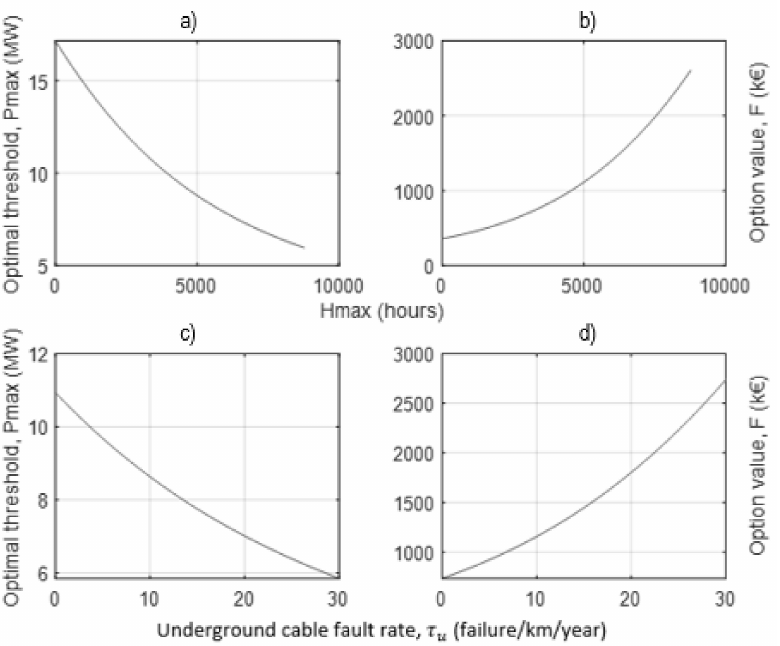
Figure 17. Sensitivity analysis of Hmax and underground cable fault rate for optimal threshold ( a , c ) and option value ( b , d ).